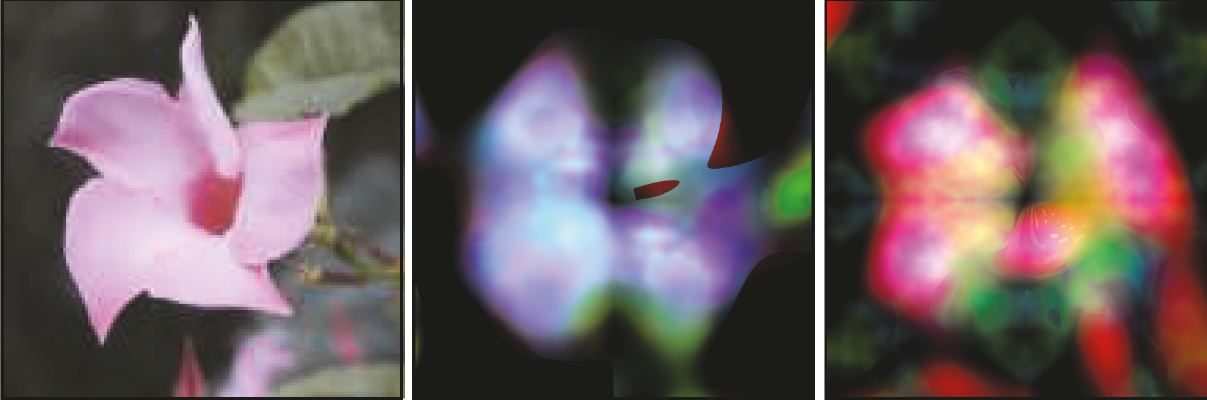
Figure 16: Colour experiment highlights; flower; noise language, no 𝑋 . The leftmost image shows the target, followed by a pair of notable evolved candidates.